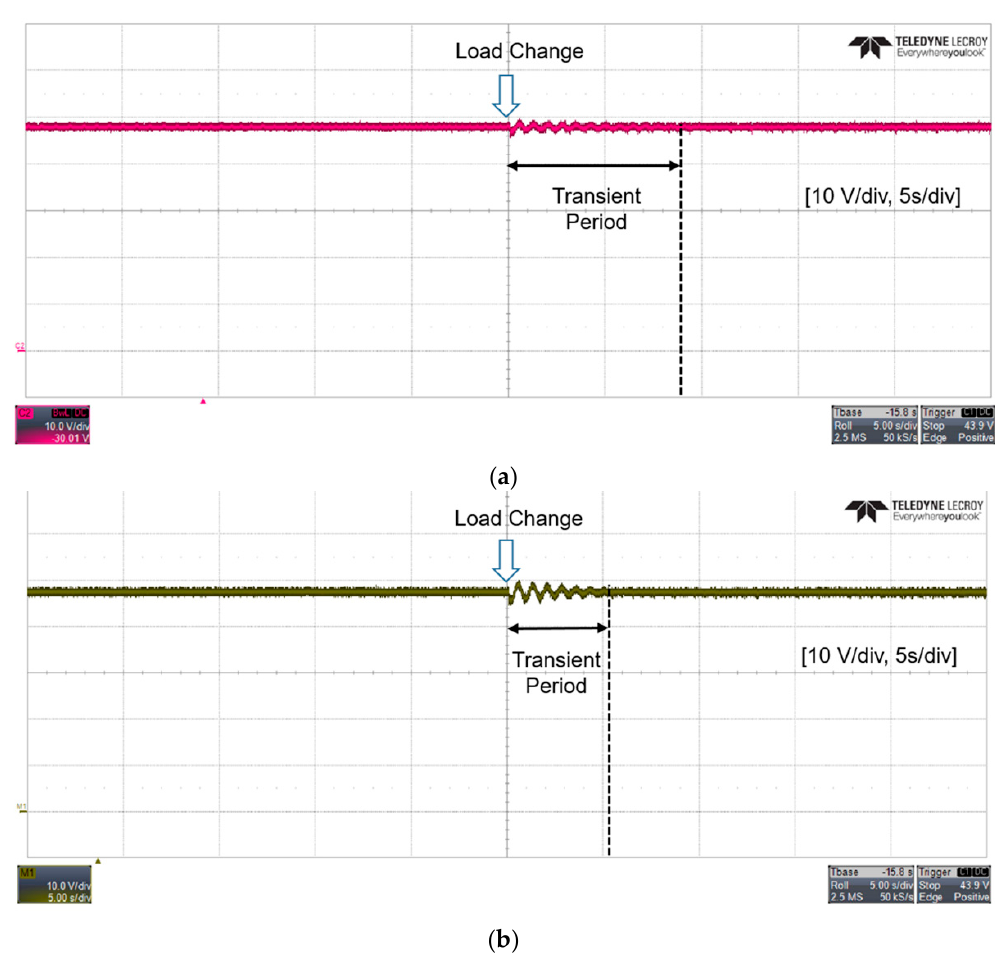
Figure 12. Voltage waveforms with different filter time constants ( a ) 50 ms; ( b ) 0.1 ms.